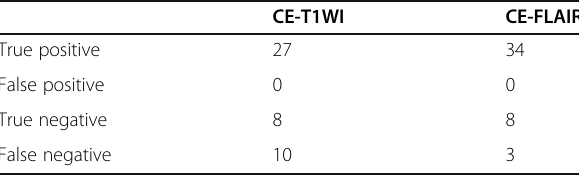
Table 1 Results of MR in total cases ( n = 45). CSF analysis was considered the gold standard (37 cases were positive and 8 cases were negative)